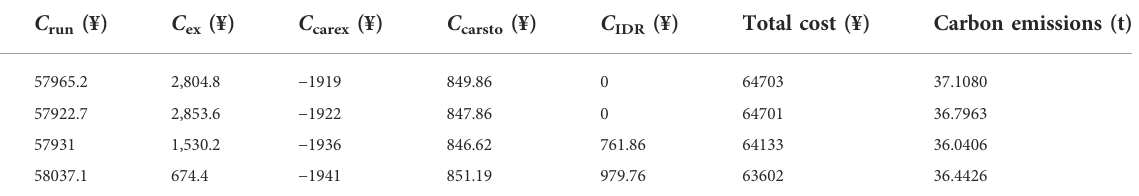
TABLE 5 Robust optimization results under different